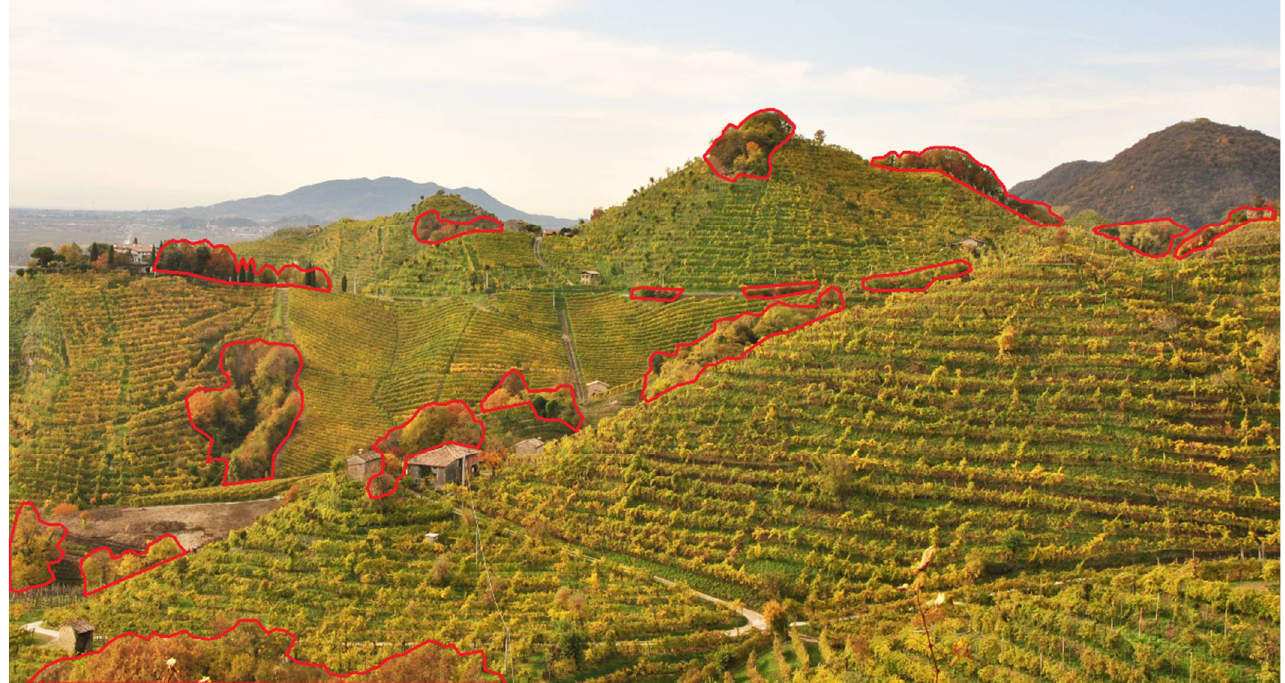
Figure 5. One of the main features of the cultural landscape of the UNESCO site Colline del Prosecco is represented by TOF NON A/U, which are found interspersed with vineyards, often cultivated on very steep slopes, or as a connection between large forest patches.